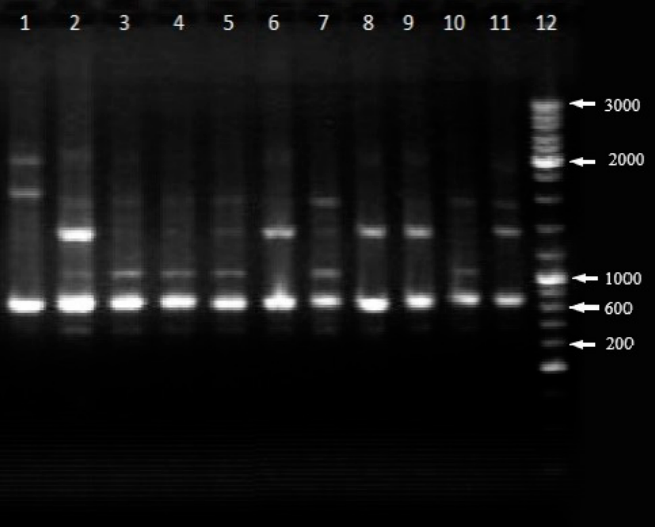
Figure 4. Random Amplification of Polymorphic DNA (RAPD)-PCR with primer OPA-13: 1— P. syringae pv. syringae UCM B-1027; 2— P. syringae pv. atrofaciens UCM B-1011; 3— P. syringae L8; 4— P. syringae L9; 5— P. syringae L11; 6— P. syringae pv. atrofaciens 9780; 7— P. syringae L11a; 8— P. sy- ringae L13; 9— P. syringae L15; 10— P. syringae L16; 11— P. syringae pv. atrofaciens UCM B-1014; 12— marker.